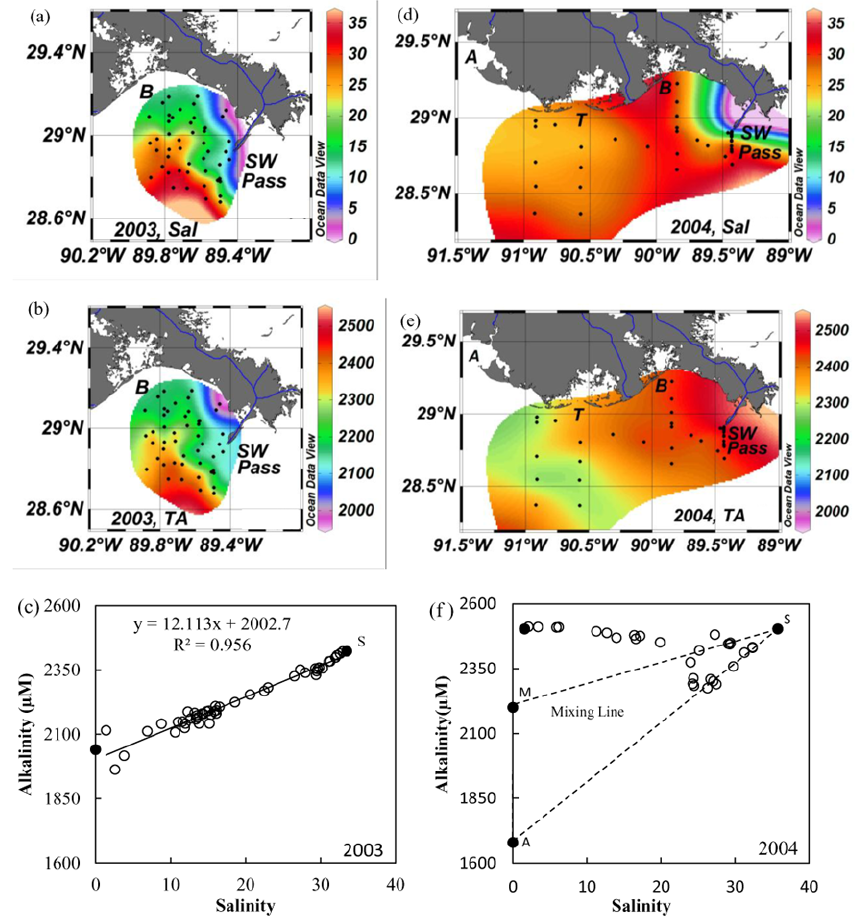
Fig. 2. Spatial distributions of salinity and TA in June 2003 ( a and b , respectively) and in August 2004 ( d and e , respectively), and relation- ships between salinity and TA for June 2003 (c) with linear regression line and for August 2004 (f) with conservative mixing lines (dashed lines). “A” represents the Atchafalaya Bay, “T” is the Terrebonne Bay, “B” is the Barataria Bay, and “SW Pass” is the Southwest Pass of the Mississippi River. Black dots on the spatial distribution stand for sampling sites. Black circles in (c, f) are the end-members. The solid line on (c) represents the linear regression line. For (f) , “M”, “A”, and “S” represent end-members of the Mississippi River, the Atchafalaya River, and seawater, respectively. The relationship between salinity and potential TA (=TA+NO − ) was very similar to the relationship between 3 salinity and TA, for NO − concentration is much lower compared to TA; thus only the latter is 3